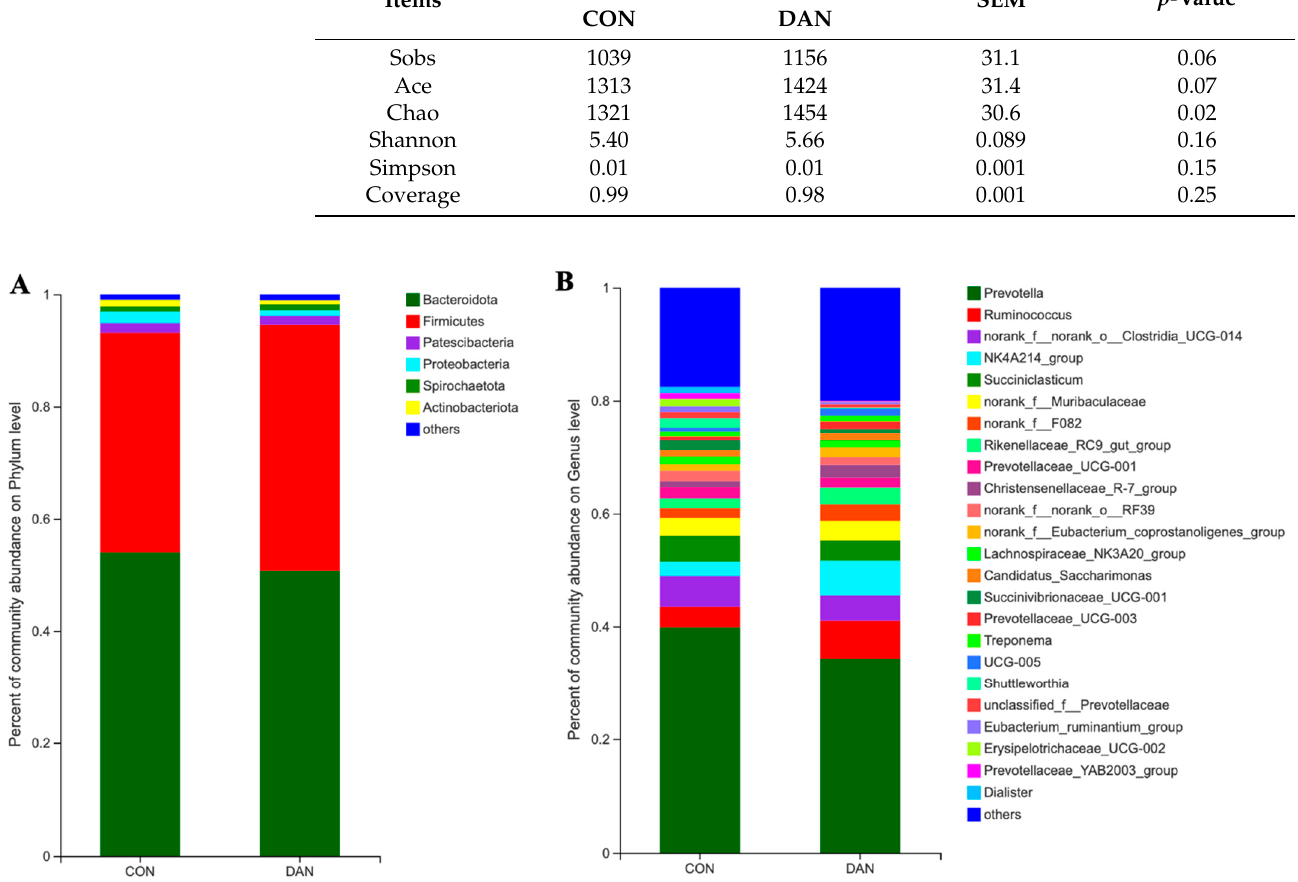
Figure 2. The distribution of rumen fluid bacterial taxa under phylum ( A ) and genus ( B ) levels between the treatments.